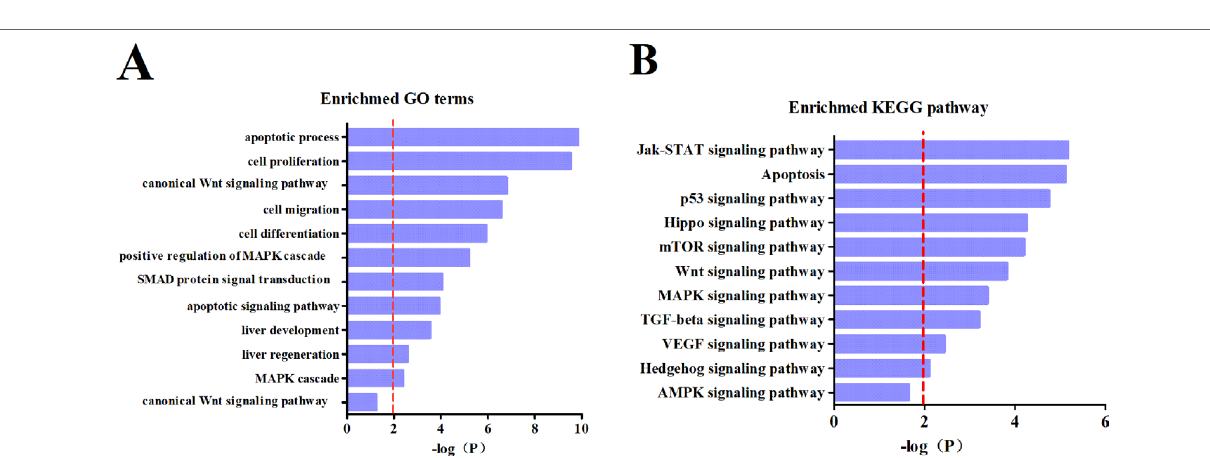
FIGURE 5 | Subpathway enrichment analysis of microRNA target. (A) Enrichment of GO terms. (B) Enrichment of KEGG